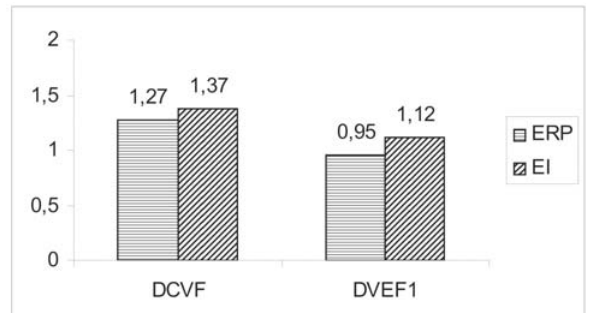
entre os grupos, em litros 1